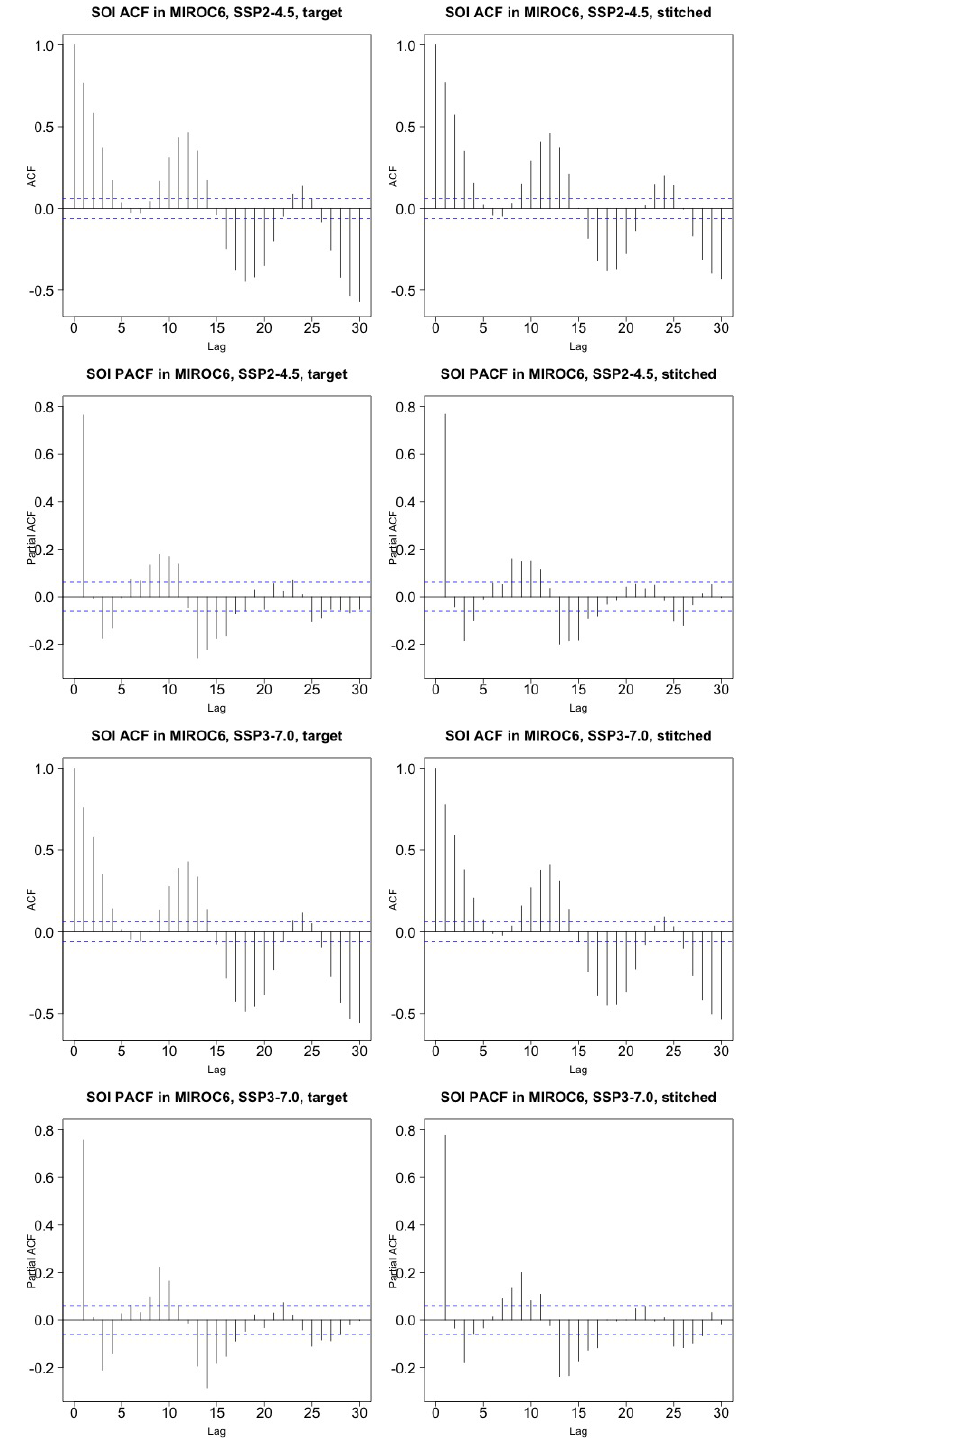
Figure D2. Auto-correlation functions (ACFs) and partial auto-correlation functions (PACFs) for real and stitched SOI time series. Top two rows: SSP2-4.5 ACF for target and stitched series and respective PACFs. Bottom two rows: SSP3-7.0 ACF for target and stitched series and respective PACFs. Results from emulation of one of three ensemble members emulated under each scenario for MIROC6. (Our software – R function acf(..,type="partial") – does not define the PACF at lag zero.)